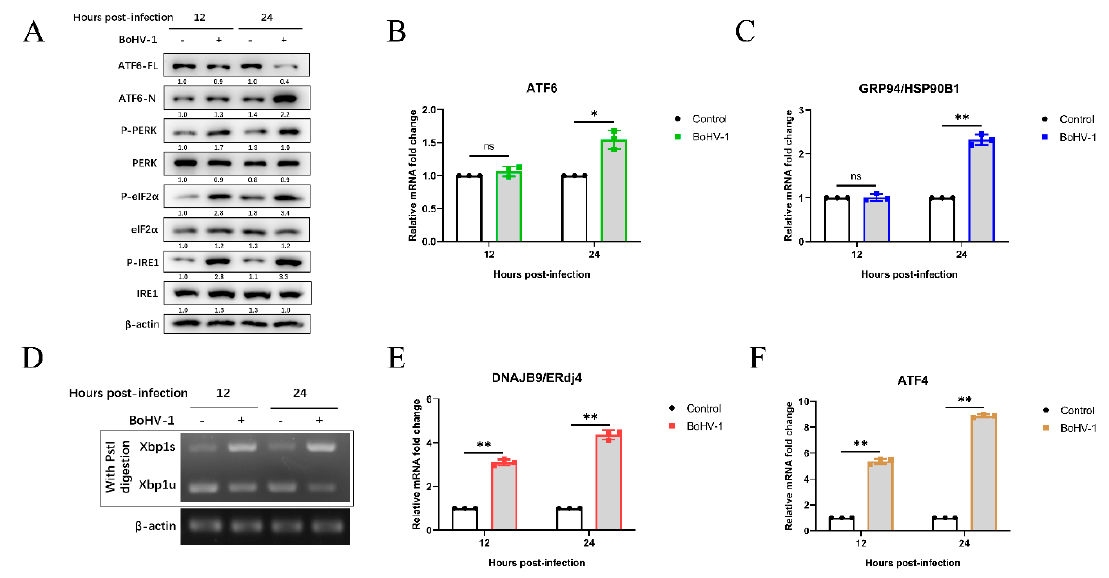
Figure 2. BoHV-1 induces UPR through all three signaling branches. ( A ) Immunoblot analysis of ATF6-FL, ATF6-N, total PERK, eIF2 α , and IRE1, phosphorylated IRE1, PERK, and eIF2 α protein levels in MDBK cells after 12 and 24 h of BoHV-1 infection at an MOI of 0.1. ( B , C , E , F ) qPCR analysis of ATF6, GRP94, ERdj4, and ATF4 mRNA expression in MDBK cells after 12 and 24 h of BoHV-1 infection (0.1 MOI). The graph shows the levels of the genes normalized against β -actin and the data are shown as fold changes and were normalized to control cell data. ( D ) XBP1 splicing assay. First, MDBK cells were infected with BoHV-1 at 0.1 MOI at 12 or 24 hpi and harvested for RT-PCR analysis of XBP1 mRNA splicing. The production of XBP1 was digested with the restriction enzyme Pst I, and then the digested PCR products were separated by 1.5% agarose gel electrophoresis. The mean ± SD of data from three independent experiments are shown; * p < 0.05, ** p <